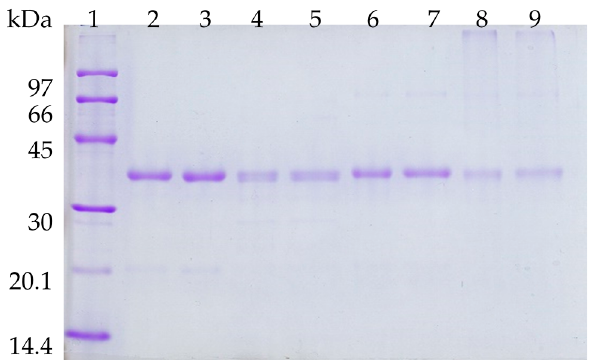
Figure 5. SDS-PAGE analysis of OCCALB and OCCALB-PEI derivatives under different treatments. Lane 1: low molecular weight protein standard from GE Healthcare. Lane 2: OCCALB; lane 3: OCCALB-PEI; lane 4: OCCALB and lane 5: OCCALB-PEI incubated at pH 5 and 80 °C. Lane 6: OCCALB and lane 7: OCCALB-PEI incubated at pH 7 and 70 °C. Lane 8: OCCALB and lane 9: OCCALB-PEI incubated at pH 9 and 60 °C.